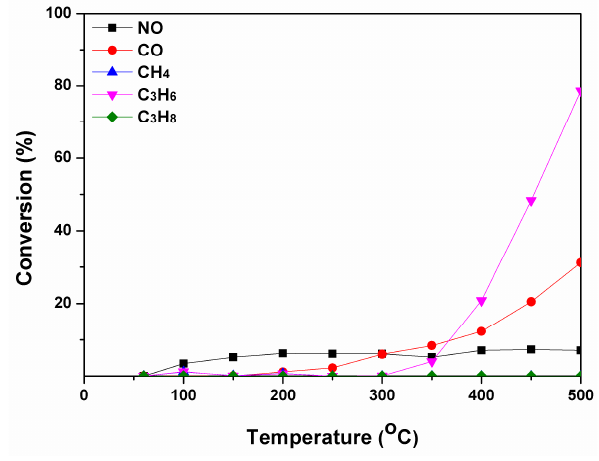
Figure 6. Light ‐ off curves of sample Cu_7.7 wt %_SiO 2 _PB.